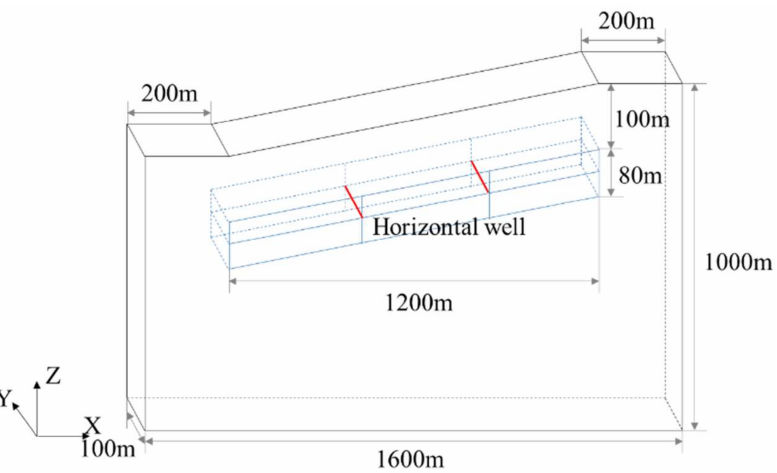
Figure 1. Geometric illustration of the basic model of a